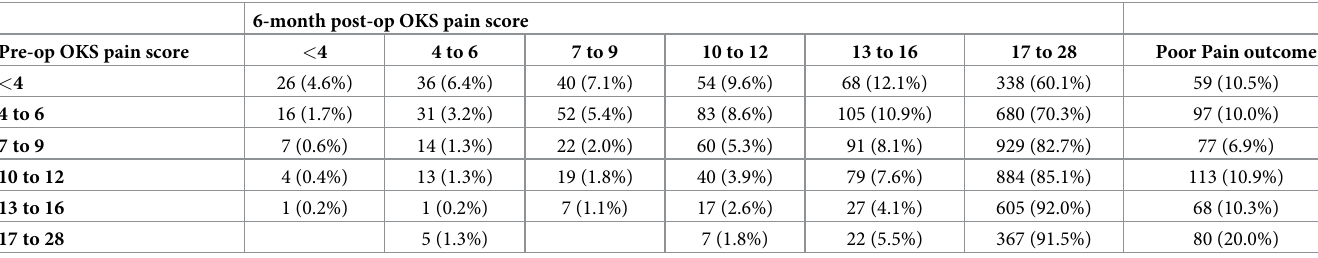
Table 2. Pain state change between pre-operative and 6-month post-operative